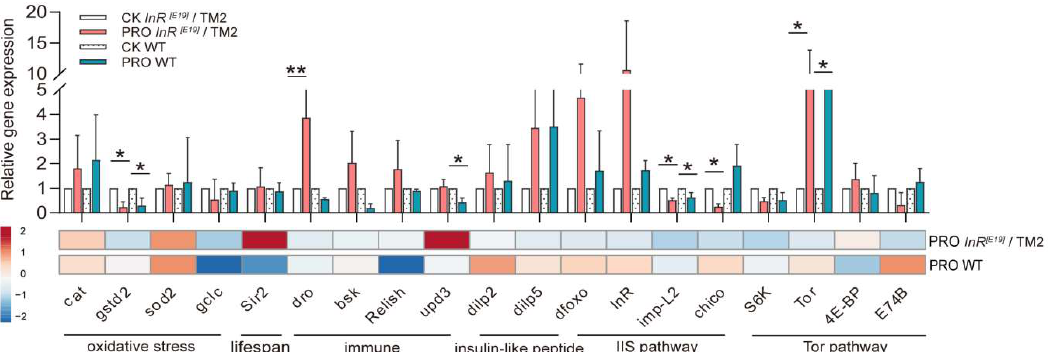
Figure 2. The effect of the probiotic combination on the relative gene transcript levels in WT and InR [E19] /TM2 D. melanogaster . Asterisks indicate a significance between the marked data (* p ≤ 0.05 and ** p < 0.01). The heat map shows the distribution of the gene differential expression. The color of the squares indicates the normalized relative expression (from 2 to -2), marked on the color block.